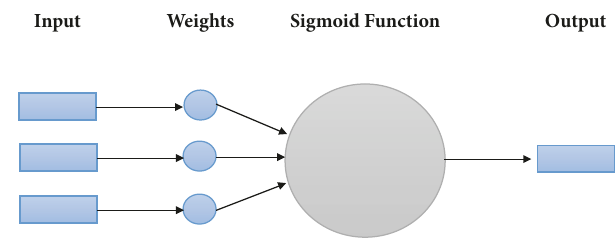
Figure 1: Artificial Neural Network